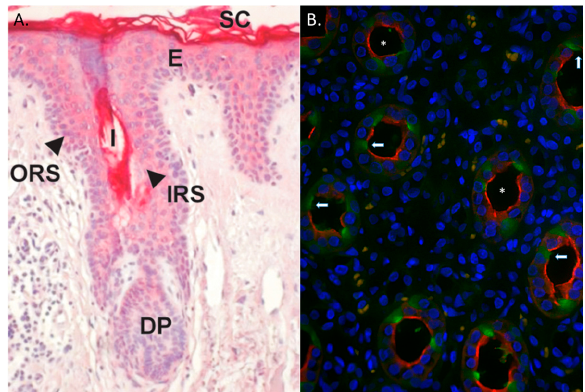
Figure 3. RNase 7 expression in human skin and kidney. ( A ) Immunostaining of RNase 7 peptide in human skin demonstrates strong RNase 7 expression in the upper epidermal layers. Hair follicles